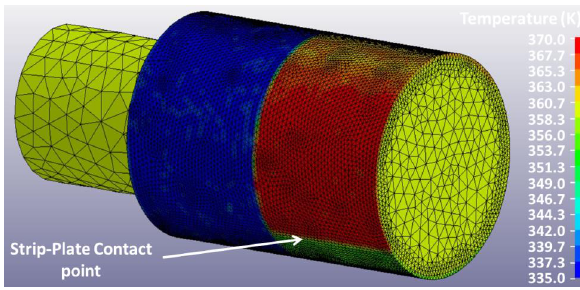
Figure 2. Roll temperature gradient during rolling.